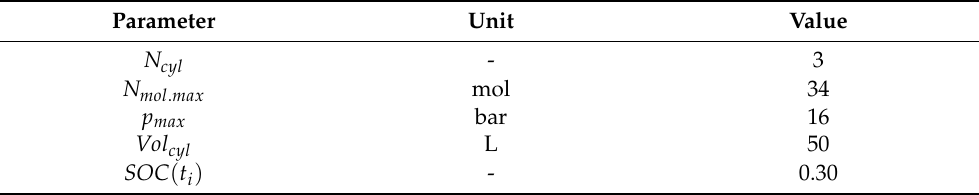
Table 4. Main input parameters of the H 2 storage